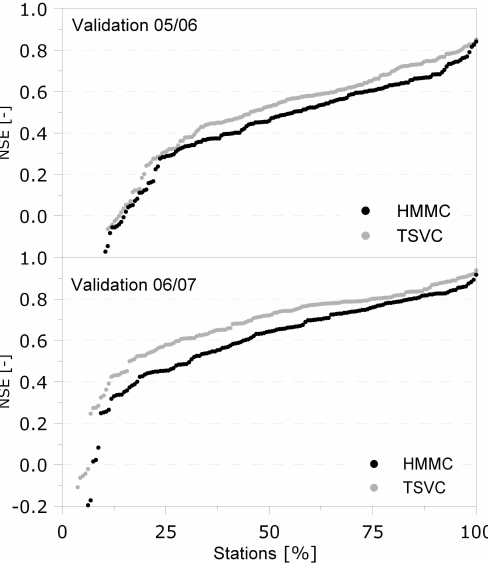
Fig. 13. Sorted model performance for RMSE of hydraulic head for both models during calibration and validation.